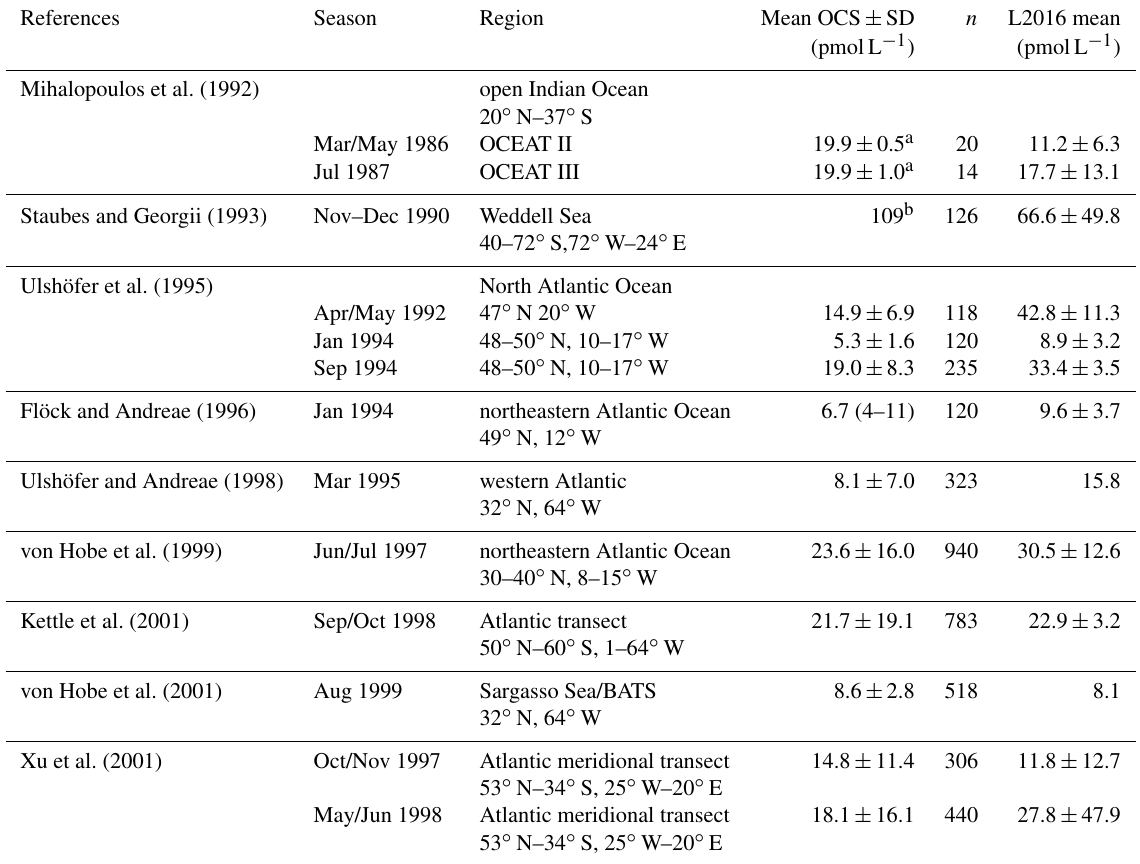
Table 5. Comparison of previous ship campaign measurements with corresponding month and approximate geolocation from the global box model in this study (L2016), taken either from figures or tables as provided in the original references. Note that the box model is based on input data from climatological means that do not fully represent the conditions encountered during the respective cruises. Only observational data with measurements of the full diel cycle were included for comparison. n : number of